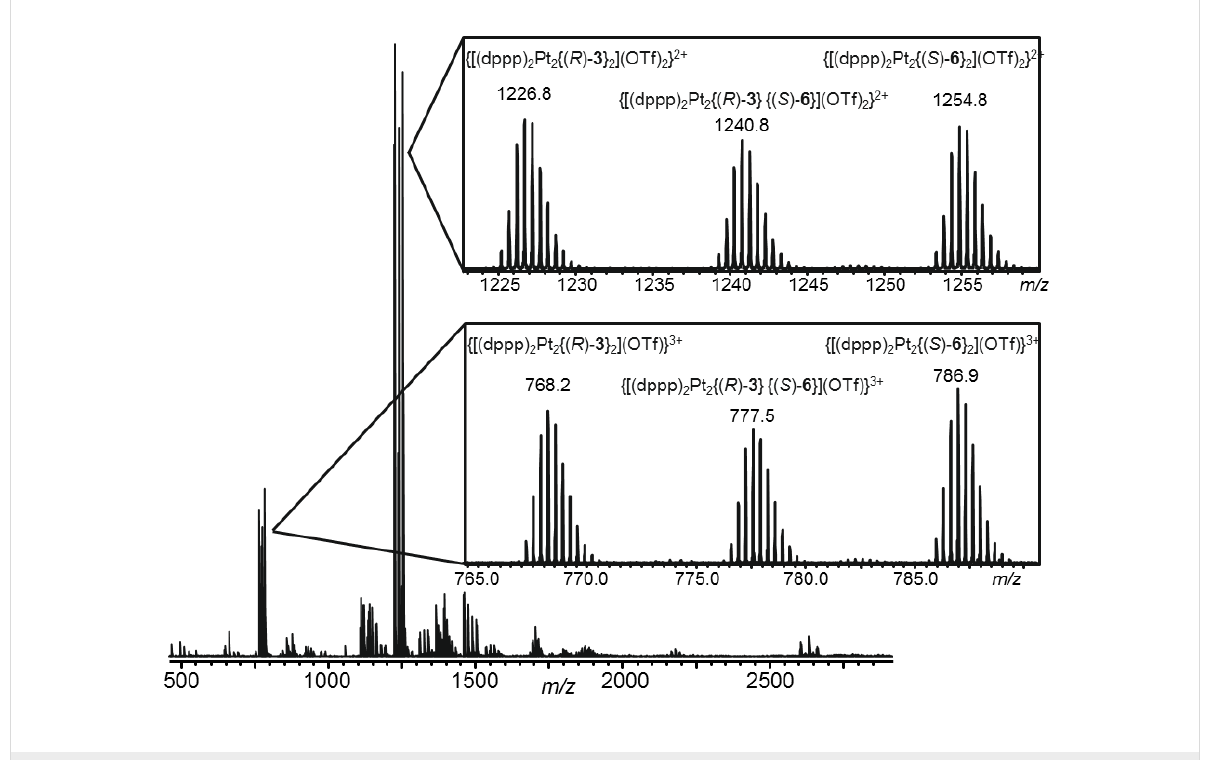
Figure 4: ESI mass spectrum (positive mode) of an 1:1:2 mixture of ( R )- 3 , ( S )- 6 , and [(dppp)Pt(OTf) 2 ] in